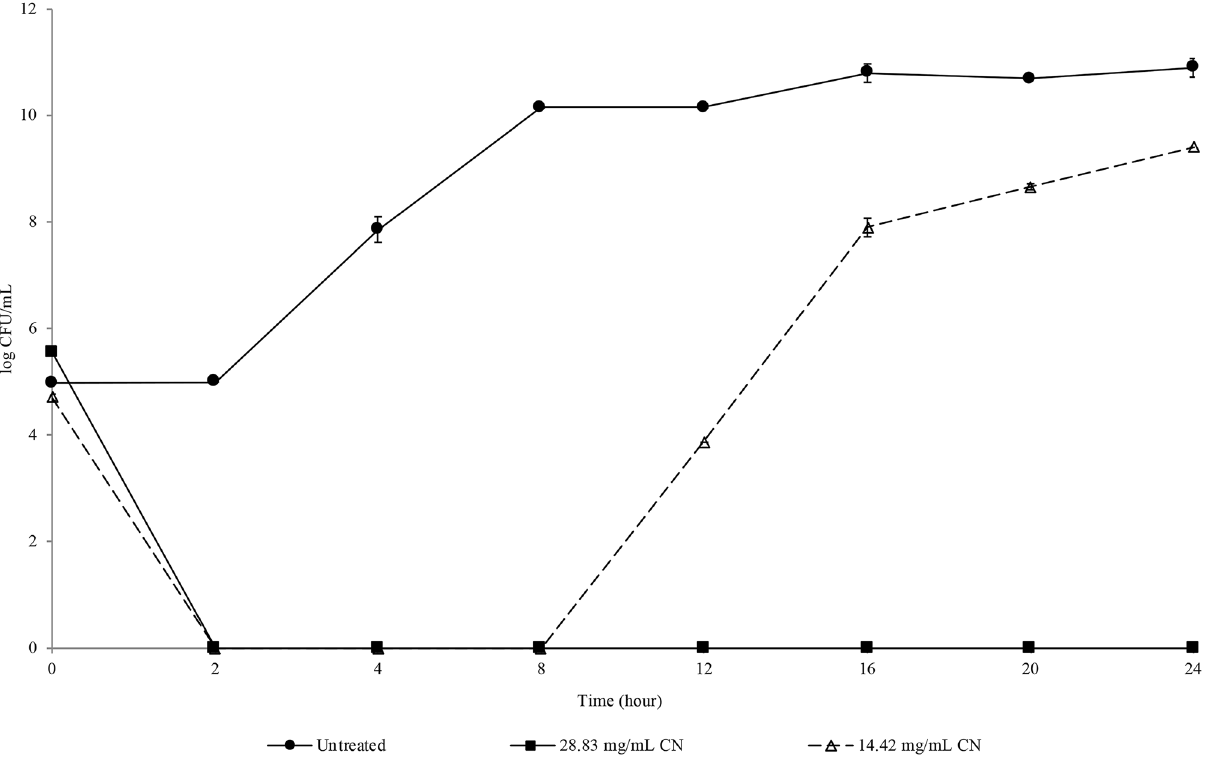
Figure 1. Killing kinetics of KPC-KP treated with CN at 28.83 mg/mL and 14.42 mg/mL for 24